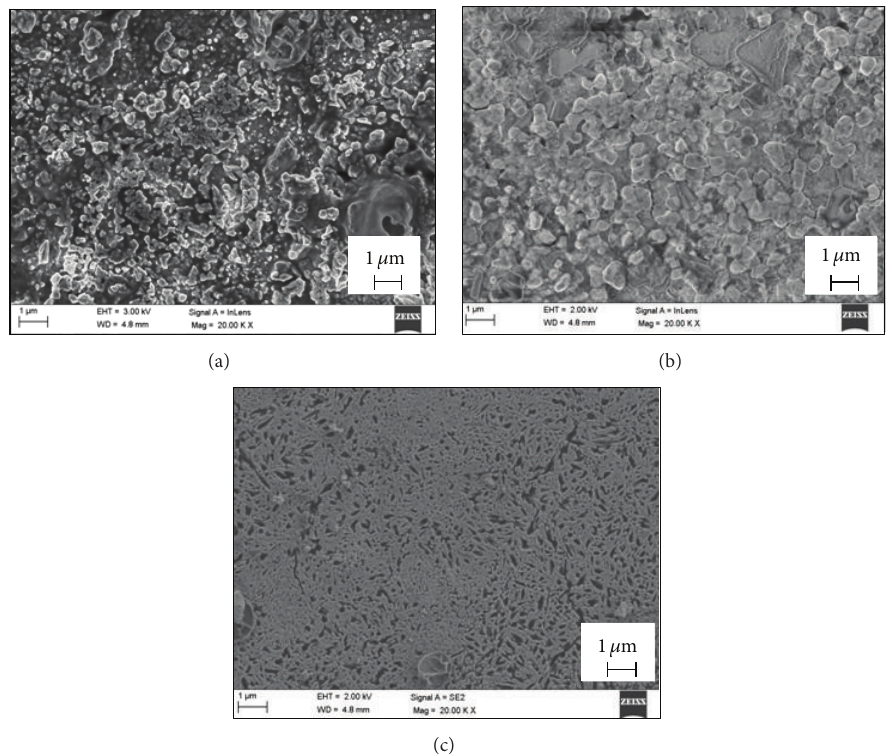
Figure 7: SEM of undoped and Cu doped ZnO thin films prepared using precursor solution of molarity of 0.15 M. Here (a), (b), and (c) correspond to samples Z2, Z2C1, and Z2C2, respectively.